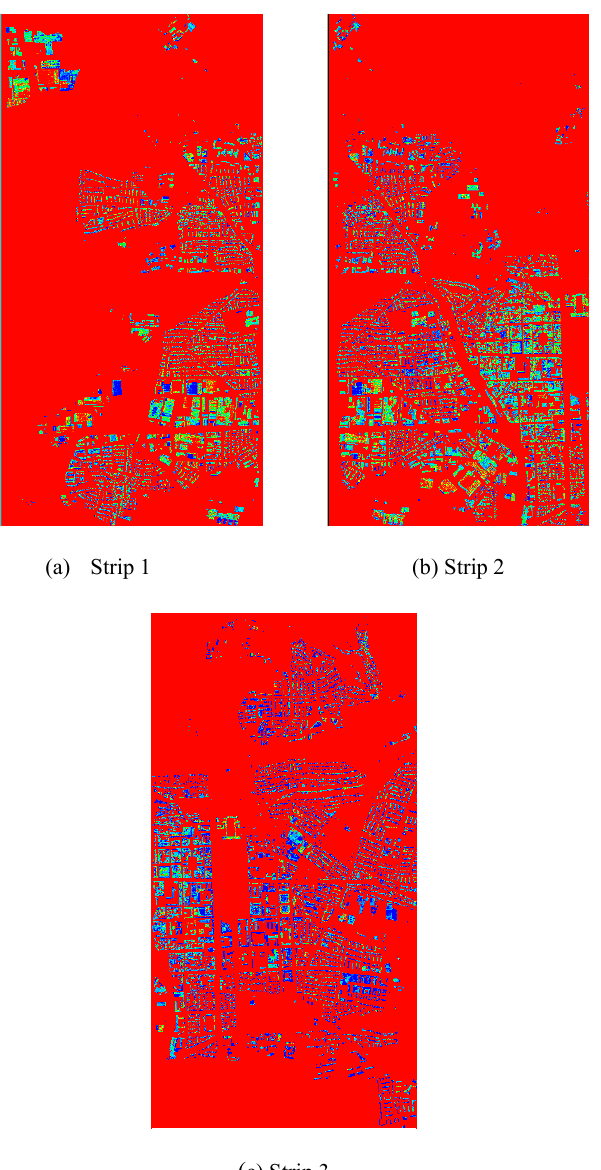
Figure 5: Classification probability maps The average likelihood probability of each of the strips is shown in Table 1. This indicates the degree of membership for each pixel to a particular roof material class.